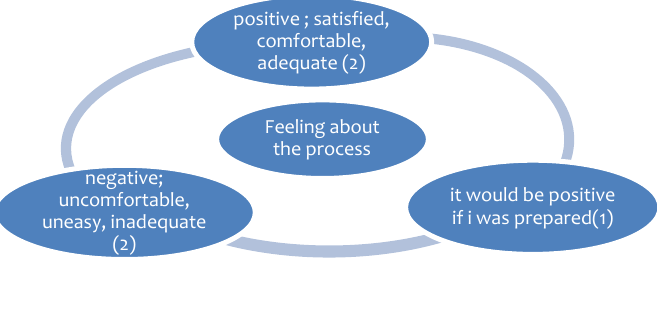
Figure 2: Expressions about how you feel while giving